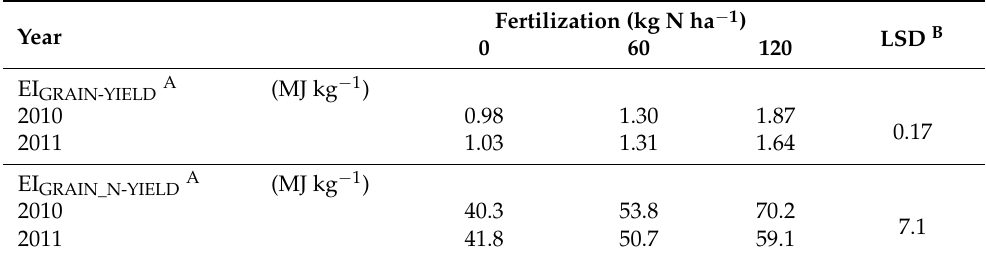
Table 11. Energy efficiency parameters of oat and pea pure crop stands and oat:pea intercrops as affected by N fertilizer level and